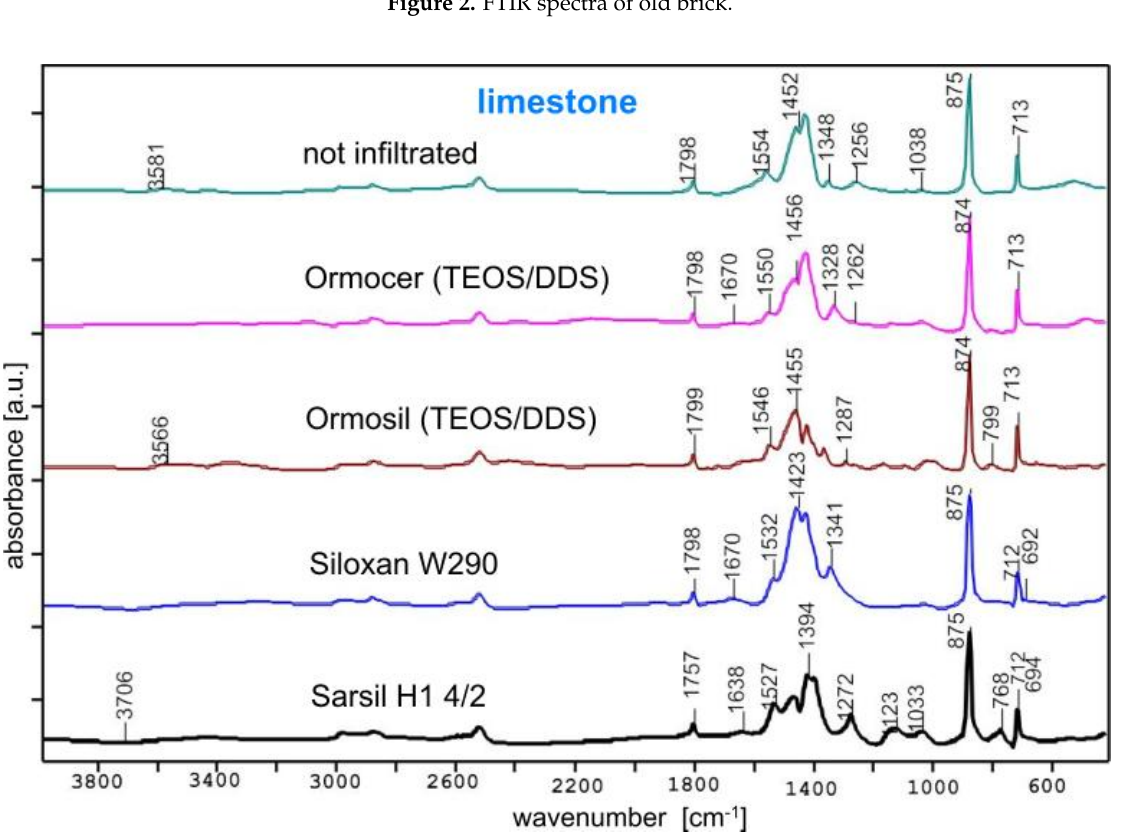
Figure 2. FTIR spectra of old brick.